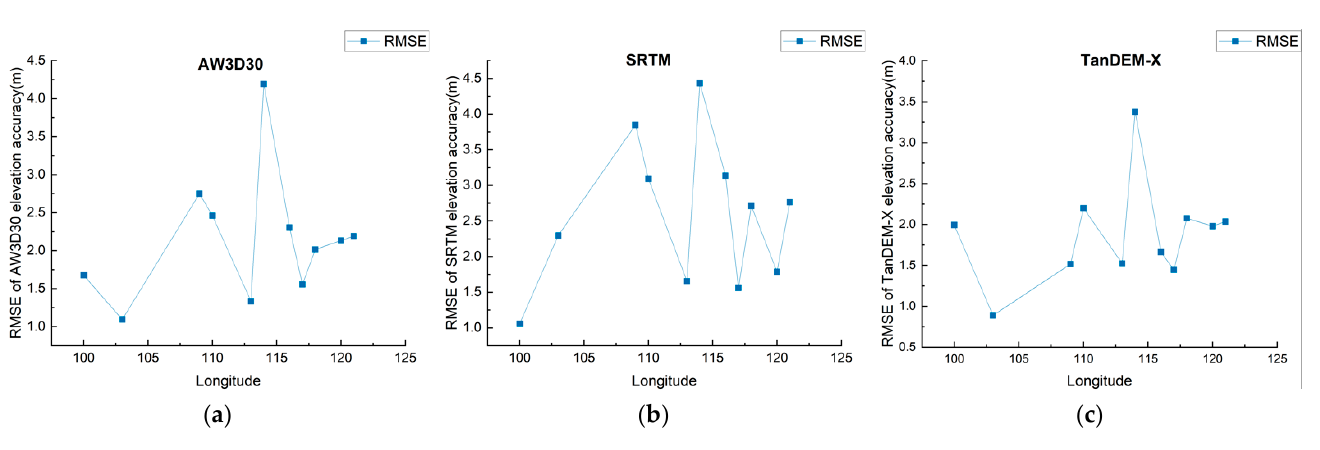
Figure 8. RMSE values of the three DEMs with respect to longitude: ( a ) AW3D30, ( b ) SRTM, and ( c ) TanDEM-X.